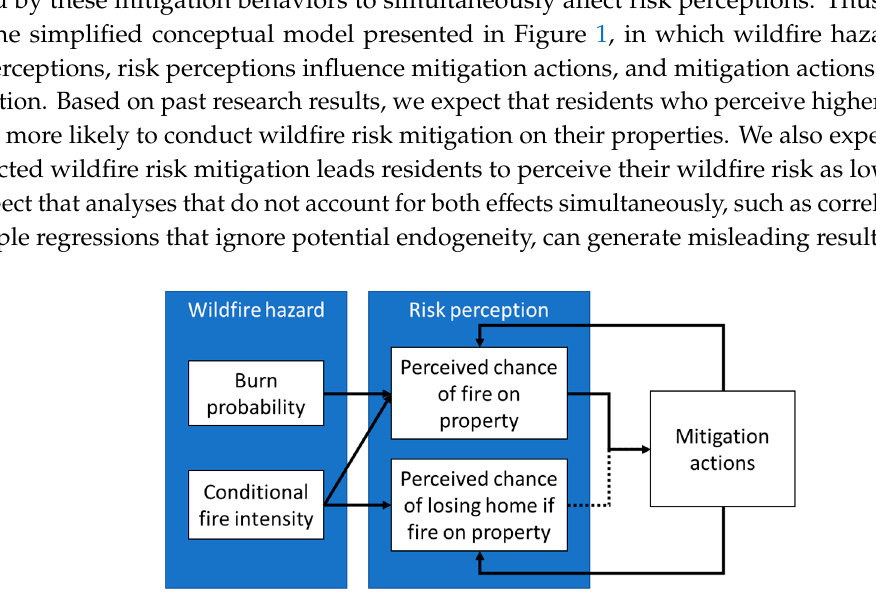
Figure 1. Conceptual model of relationship between wildfire hazard, risk perceptions, and mitigation actions. Dotted line depict relationship expected but not found in empirical results below.